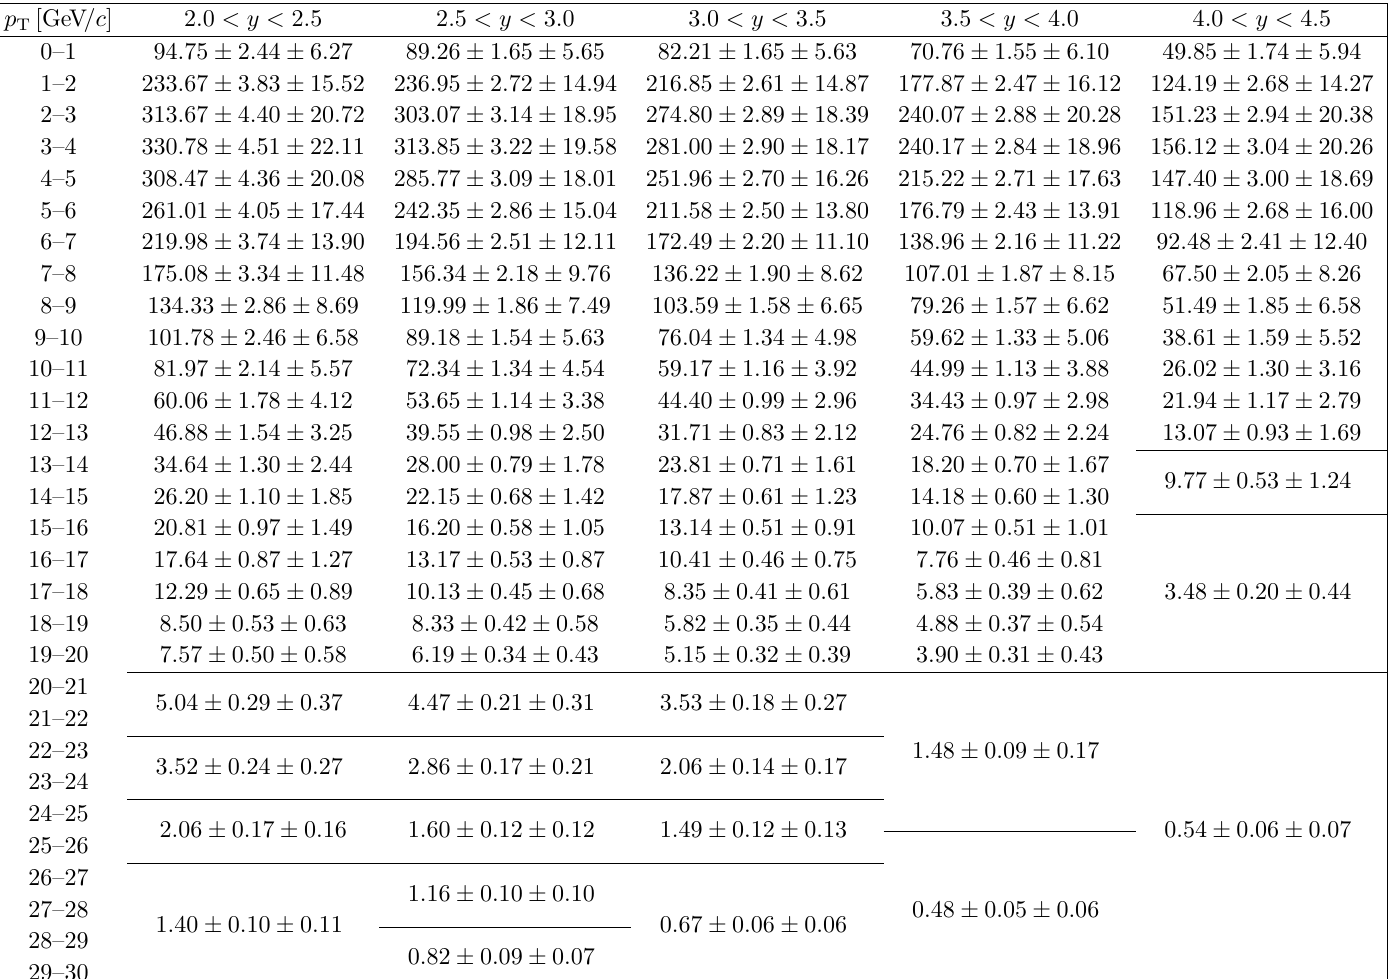
Table 2 . Double-di(cid:11)erential cross-sections times dimuon branching fraction in di(cid:11)erent bins of p T and y for (cid:7) (1 S ) (in pb). The (cid:12)rst uncertainty is statistical and the second is